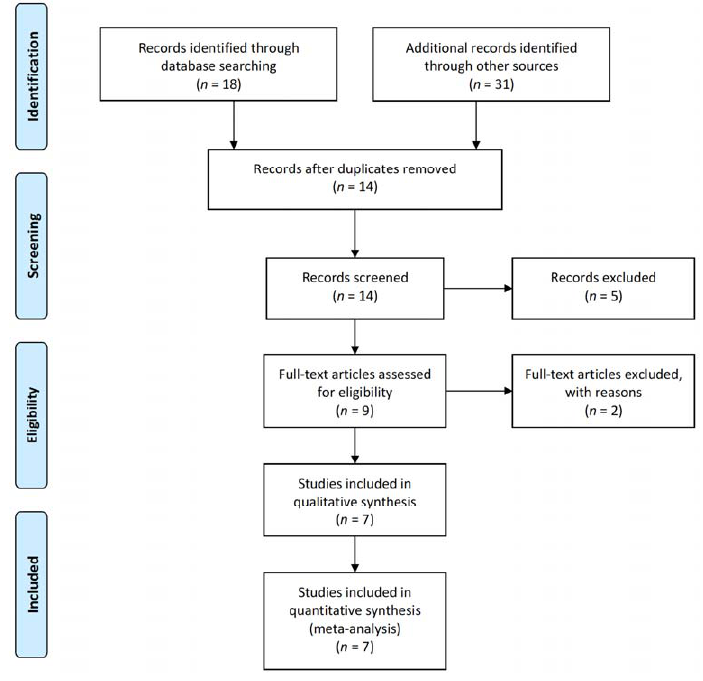
Figure 1. PRISMA flow diagram.